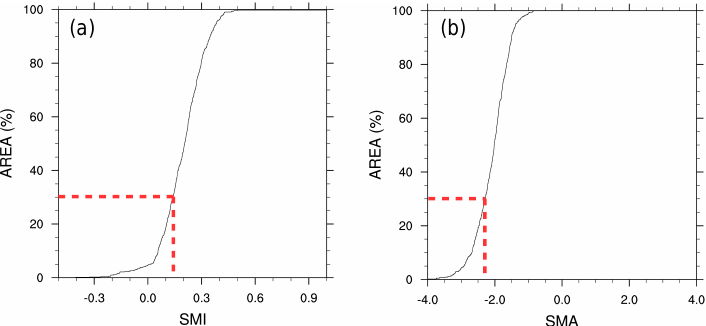
Figure 6. Cumulative area distribution of the (a) SMI and (b) SMA over southern Finland in the driest 28-day period of southern Finland in 2006 (i.e. the driest day of 28-day-running means of the regionally averaged SMI and SMA over southern Finland). The red dashed lines indicate the corresponding SMI and SMA values at which 30% of the area is affected by the Extreme Drought that affects Forest health